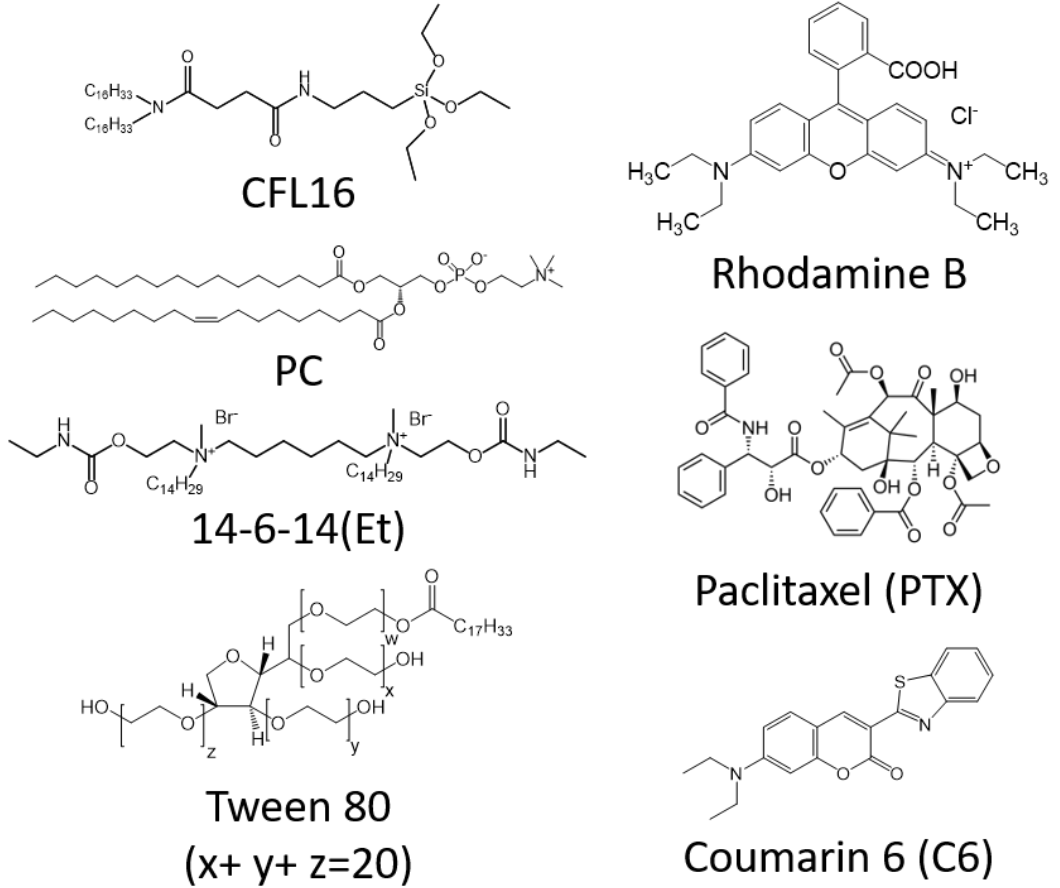
Figure 1. Structural formulas of the compounds used in this work.